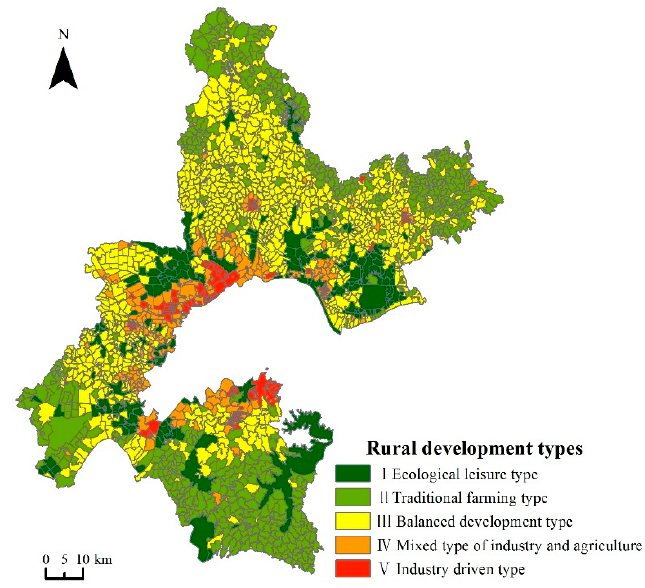
Figure 6. Spatial distribution of rural development types in administrative villages of Wuhan City’s new urban districts in 2017.